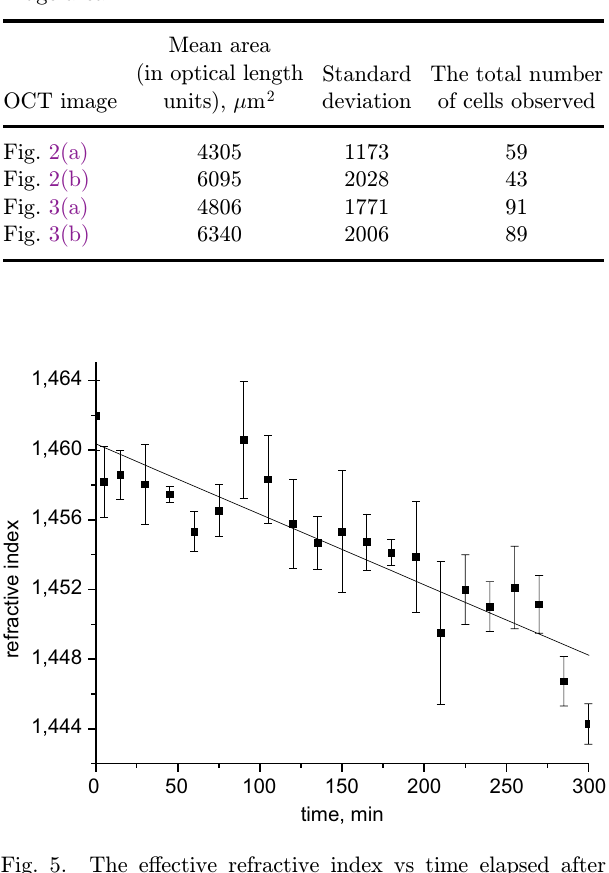
Fig. 6. The e®ective refractive index vs time elapsed after PDT for ICG-stained fat tissue slice (CW laser diode-ir- radiation during 5 min). These are the statistical results for three independent measurements; solid line shows the linear ¯t by n ¼ 1 : 386 (cid:1) 1 (cid:3) 10 (cid:1) 4 t (min).